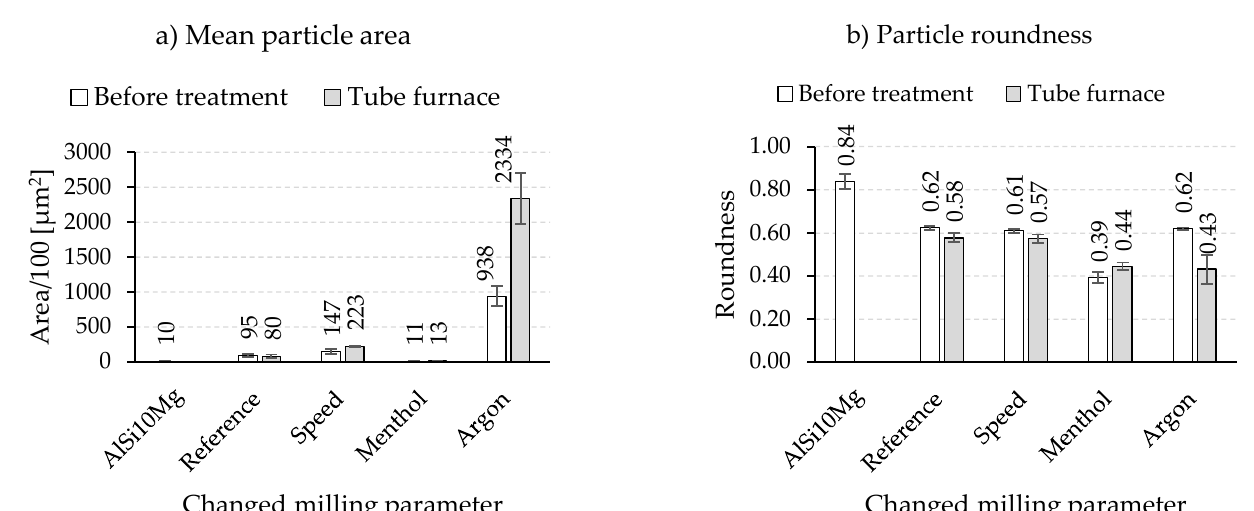
Figure 9. Light microscopic images of the HEBM composite powders produced by ( a ) Reference, ( b ) Program1 (Speed), ( c ) Porgram2 (Menthol), and ( d ) Porgram3 (Argon) after a thermal post-treatment in a tube furnace (TF) at 515 °C for 3.5 h.